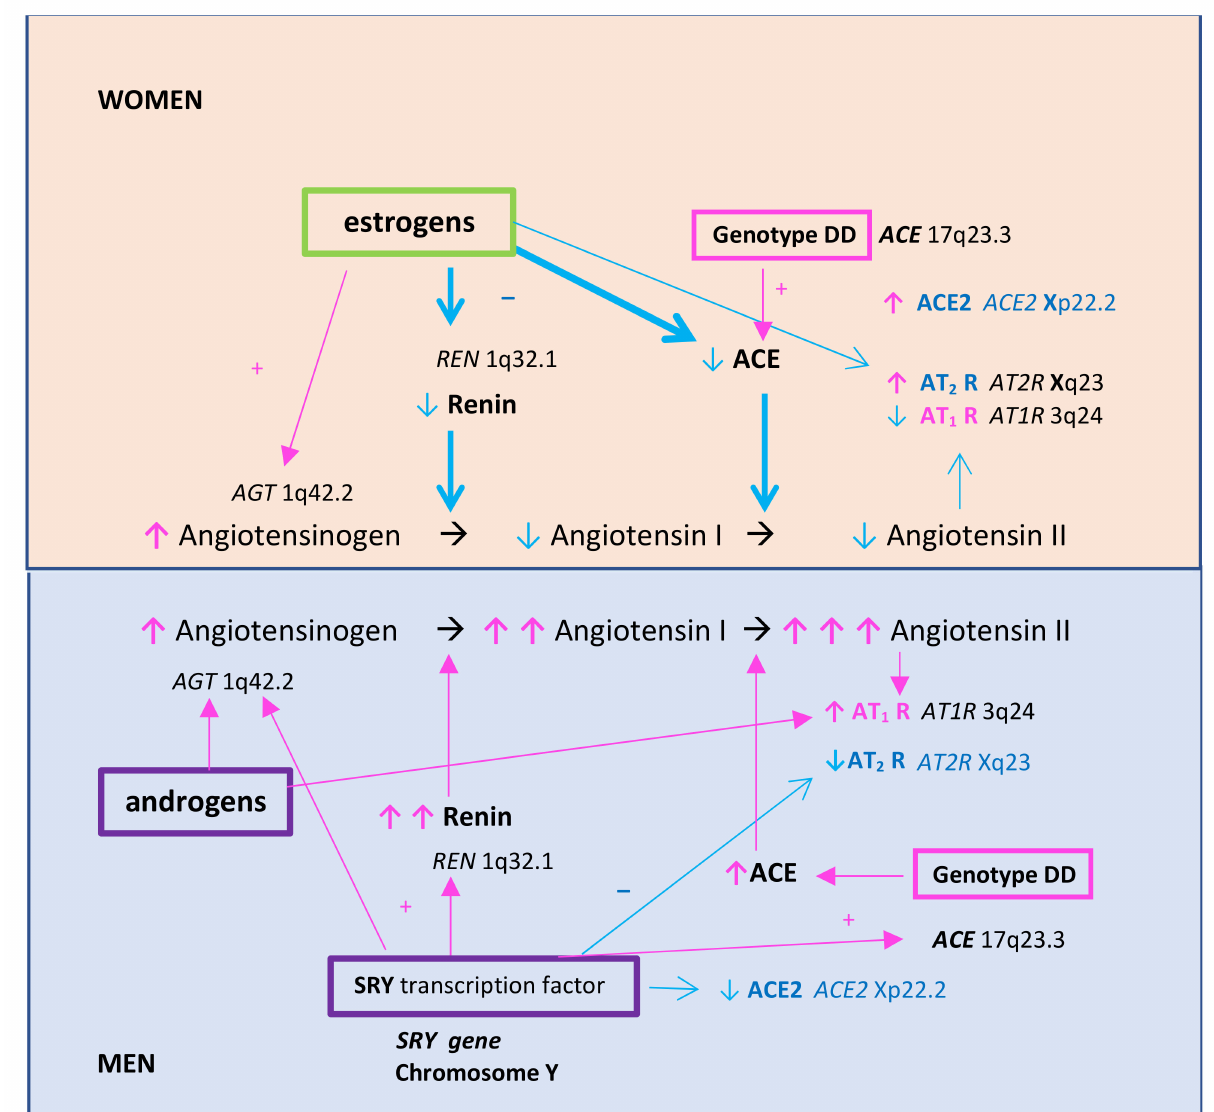
Figure 2. Differences in the regulation of the renin–angiotensin system in women vs. men. Abbreviations: ACE, angiotensin- converting enzyme; +, addition; AGT , angiotensinogen gene; AT 1 R, angiotensin II receptor type 1; AT 2 R, angiotensin II receptor type 2; DD, dominant homozygote of the insertion/deletion polymorphism of the angiotensin-converting enzyme gene; ↓ , decrease; ↑ , increase; − , inhibition; REN , renin